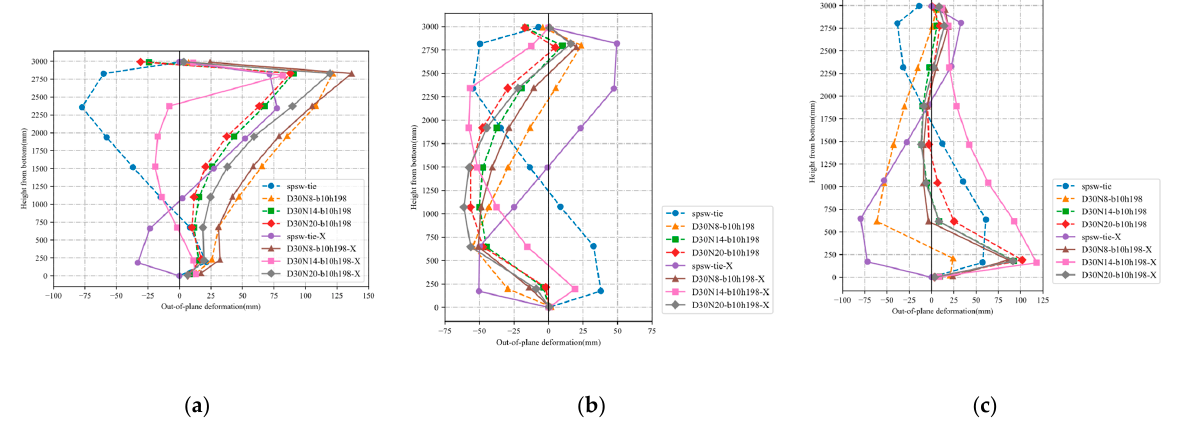
Figure 17. Out-of-plane deformation of steel plate of each model at the drift ratio of 0.02 under cyclic loading (in the tension direction of loading ends): ( a ) edge far from the loading end of steel plate; ( b ) center along the height direction of steel plate; ( c ) edge near the loading end of steel plate.